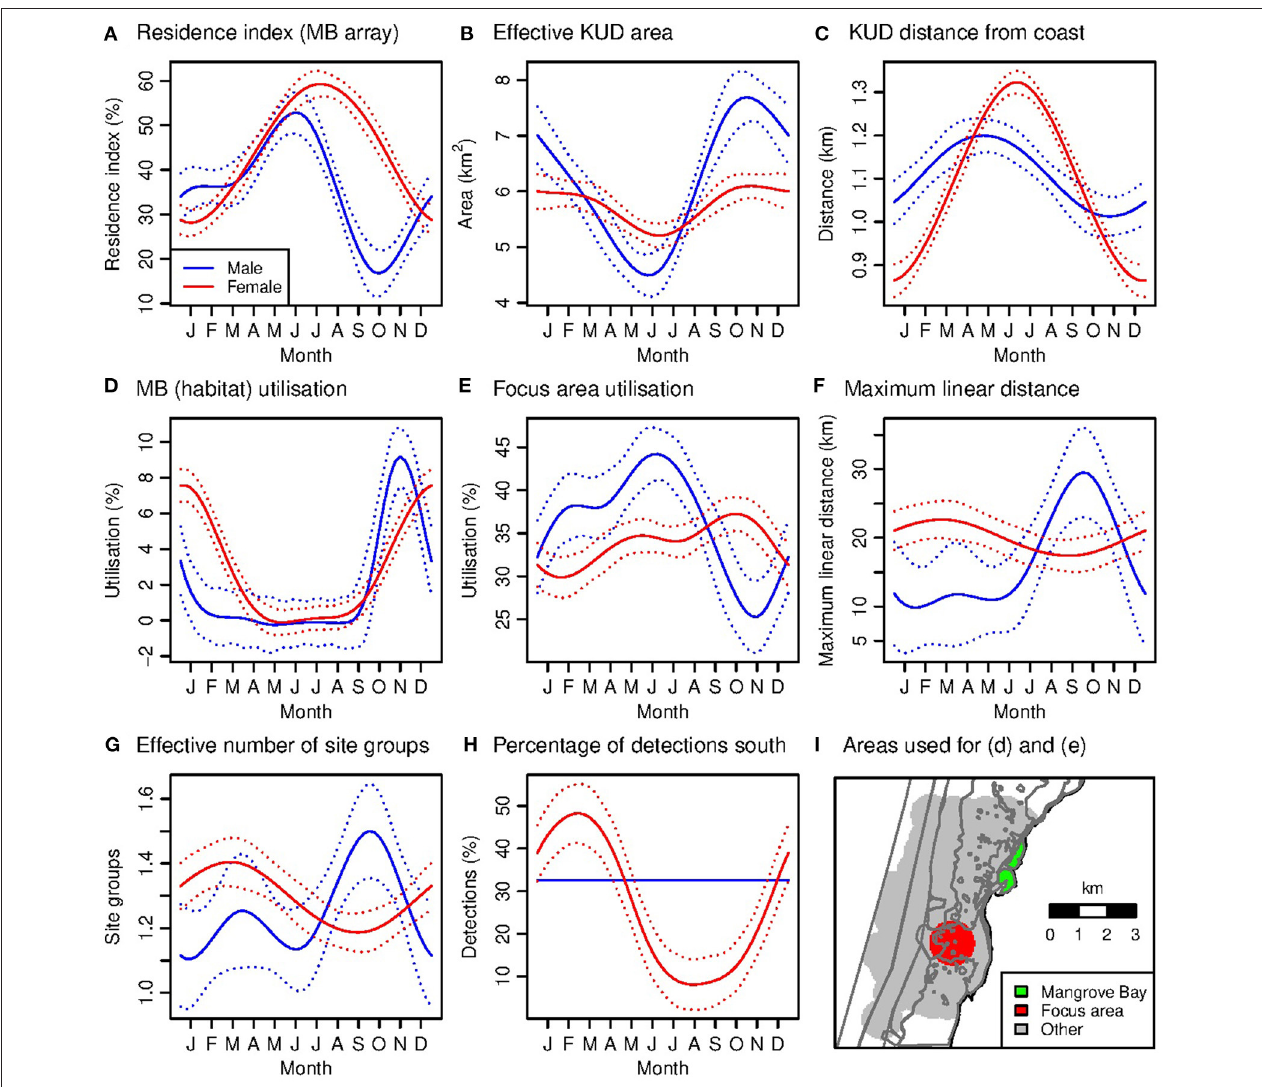
FIGURE 6 | (A–I) Generalized additive model predictions of seasonal variation in habitat utilization within Mangrove Bay (A–F) and among site groups (G,H) . The predictions are the average over tags. The dotted lines indicate the 95% confidence interval for the month term only, and therefore indicate the significance of seasonal variation but not differences between males and females in a given. The focal area used to calculate MB and focal area utilization is shown in (H)